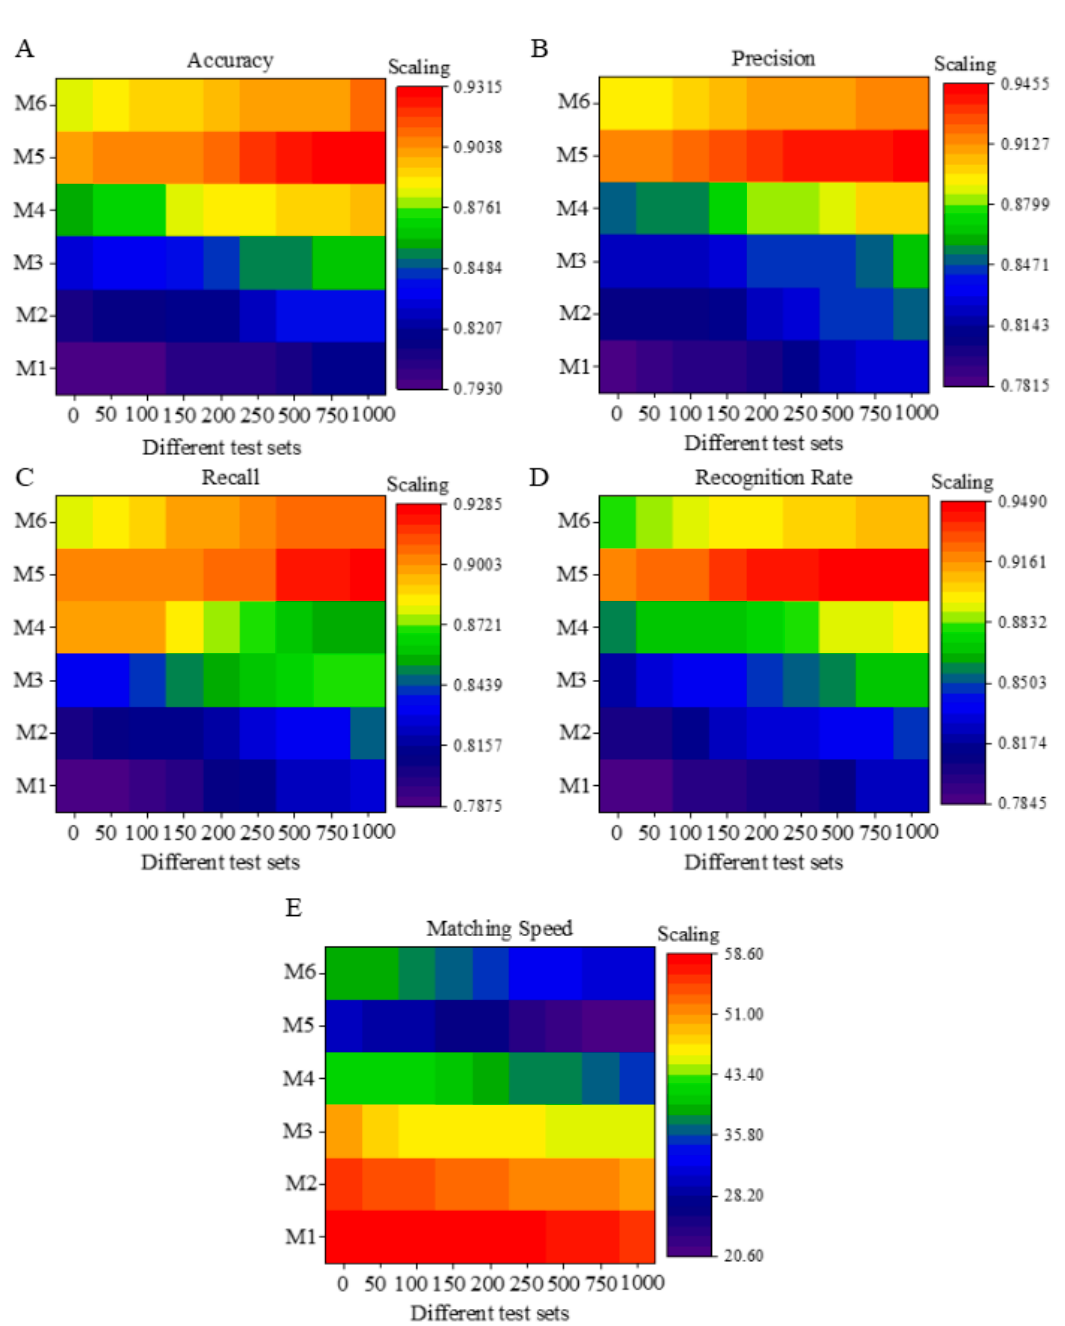
Figure 8. Performance comparison results of di ff erent models (Note: M1 is the ANN model, M2 is the Recurrent Neural Network (RNN) model, M3 is the GCN model, M4 is the LSTM model, M5 is the GCN–LSTM, and M6 is the RNN–LSTM model, where 0–200 is the test set and 200–1000 is the training set). Figures ( A – E ) show the performance results of di ff erent algorithms in accuracy, precision, recall, recognition rate, and processing speed under di ff erent test